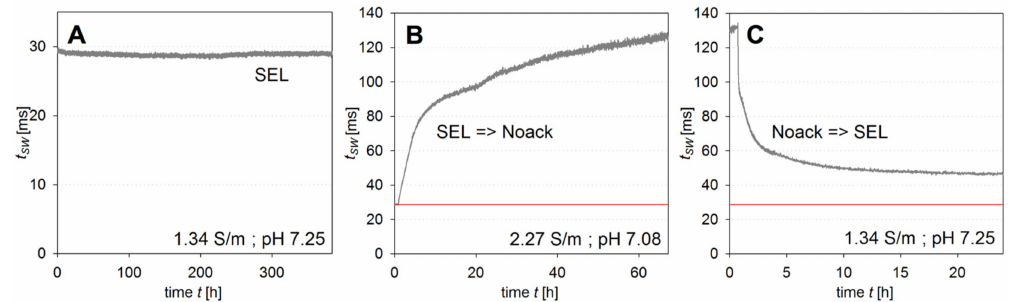
Figure 1. ( A ) Switching time t sw of the sensor probe in standard electrolyte (SEL) over 16 days. ( B ) Measurement in Noack medium exhibiting with drifting t sw values ( C ). Subsequent measurement in SEL brought t sw values almost back to its starting point, the red line marks the mean value of the 16-day measurement shown in ( A